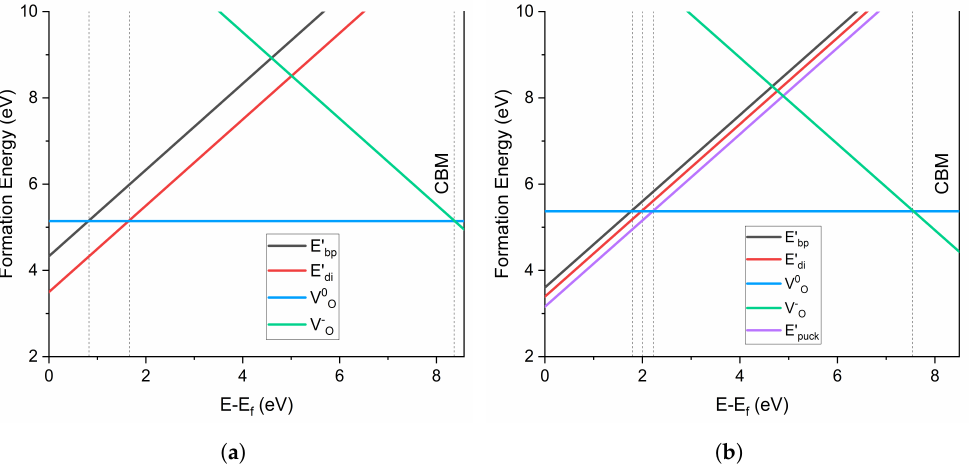
Figure 6. Charge transition level diagram of oxygen vacancy defects in ( a ) α -cristobalite and ( b ) α - quartz. 0 eV is the valence band maximum and the graph cuts off at the conduction band